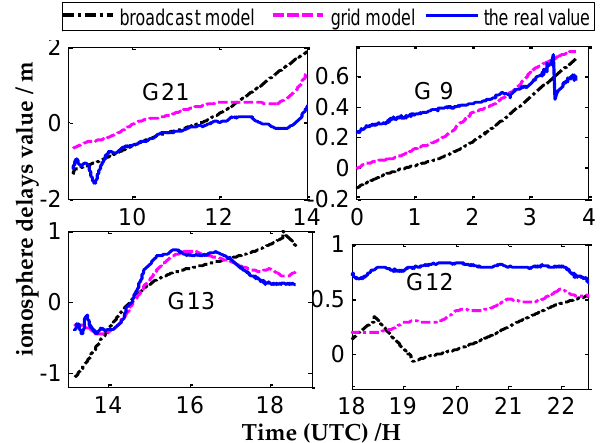
Figure 7. The ionosphere delay values under three ionosphere methods of TLSE and WTZR.